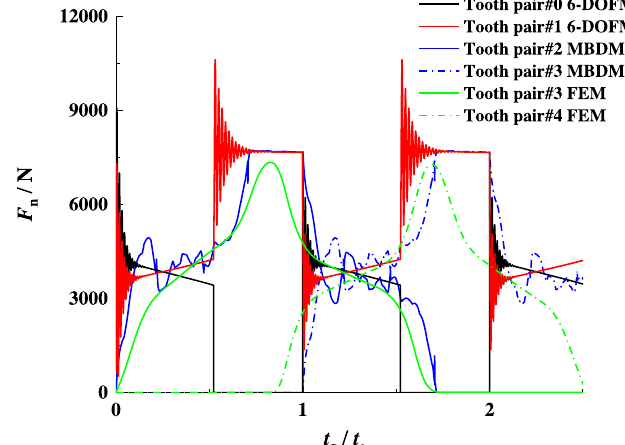
Fig. 9. Normal tooth loads of three models.